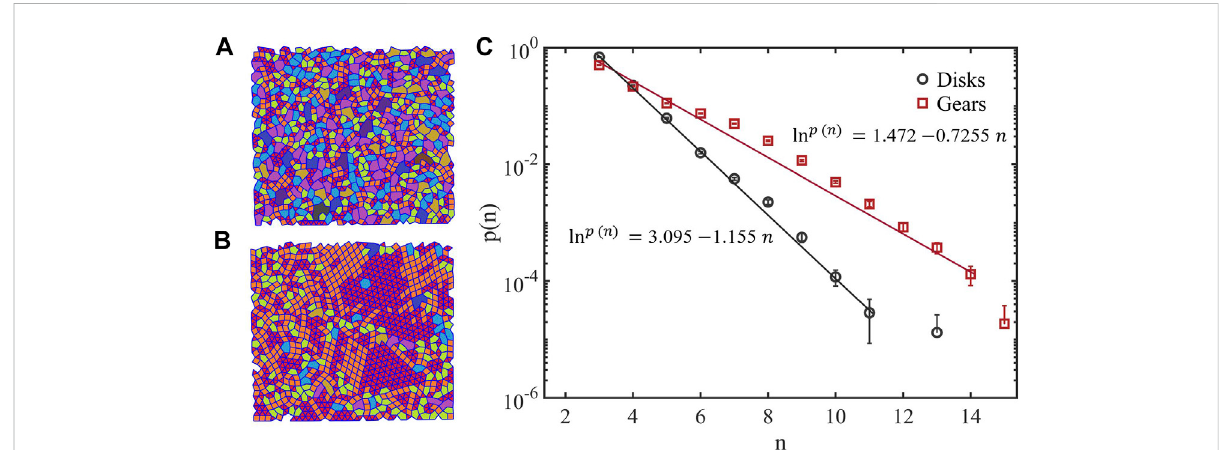
FIGURE 3 The structure characteristics of gear particles and disk particles; (A) Cell distribution of gear particles; (B) Cell distribution of disk particles, different colors are used in the fi gure to distinguish cells with different orders; (C) Cell order probability of gear particles and disk particles. The abscissa n representscellorder,andtheordinate P(n) representstheoccurrenceprobabilityofcellorder n .Theleast-squaremethodisusedto fi tthe raw data, and the fi tting error is less than 5%.